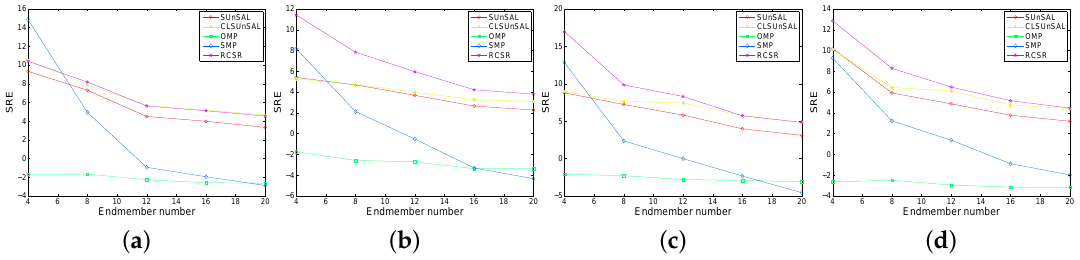
Figure 2. Performance of SRE as a function of the number of endmembers under Gaussian white noise when the SNR is 50 with the ( a ) LMM; ( b ) FM; ( c ) GBM and ( d ) MGBM.